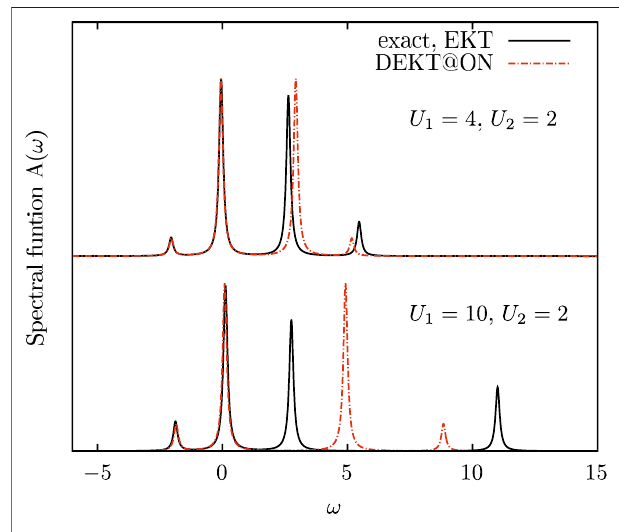
FIGURE 1 | Spectral function of the Hubbard dimer with two different on-site interactions U 1 and U 2 for site 1 and site 2, respectively: exact solution (black curves) vs. EKT (black curves, EKT is exact in this case, see text) and DEKT/MEET in the basis of natural orbitals (red